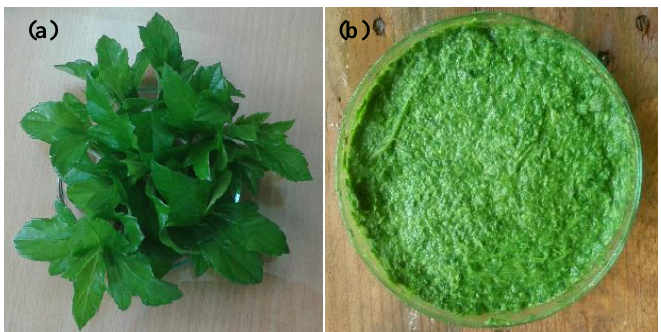
Figure 1. (a) Sphagnetcola triloata leaf and (b) leaf